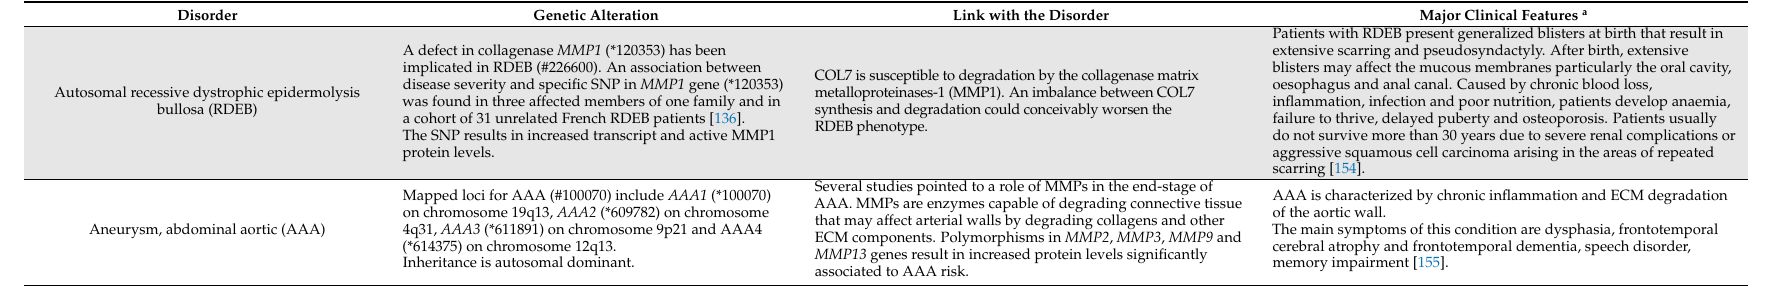
Table 2. Hereditary disorders associated to reduced synthesis or excessive degradation of specific collagen